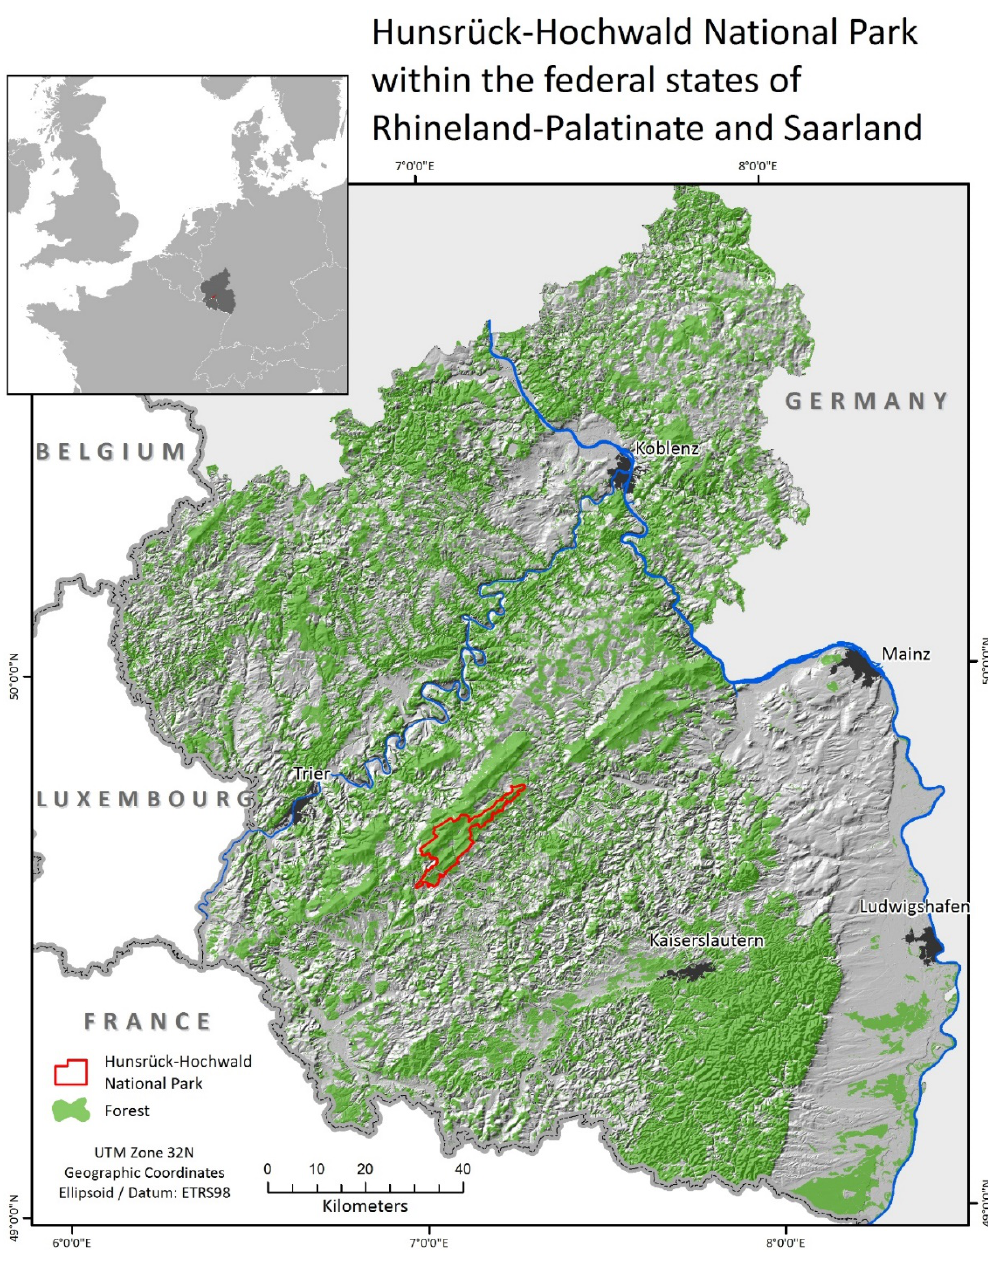
Figure 1. Map of the Hunsrück-Hochwald National Park. (Lamprecht et al . 2020). menziesii ), larch ( Larix decidua ) and fir ( Abies